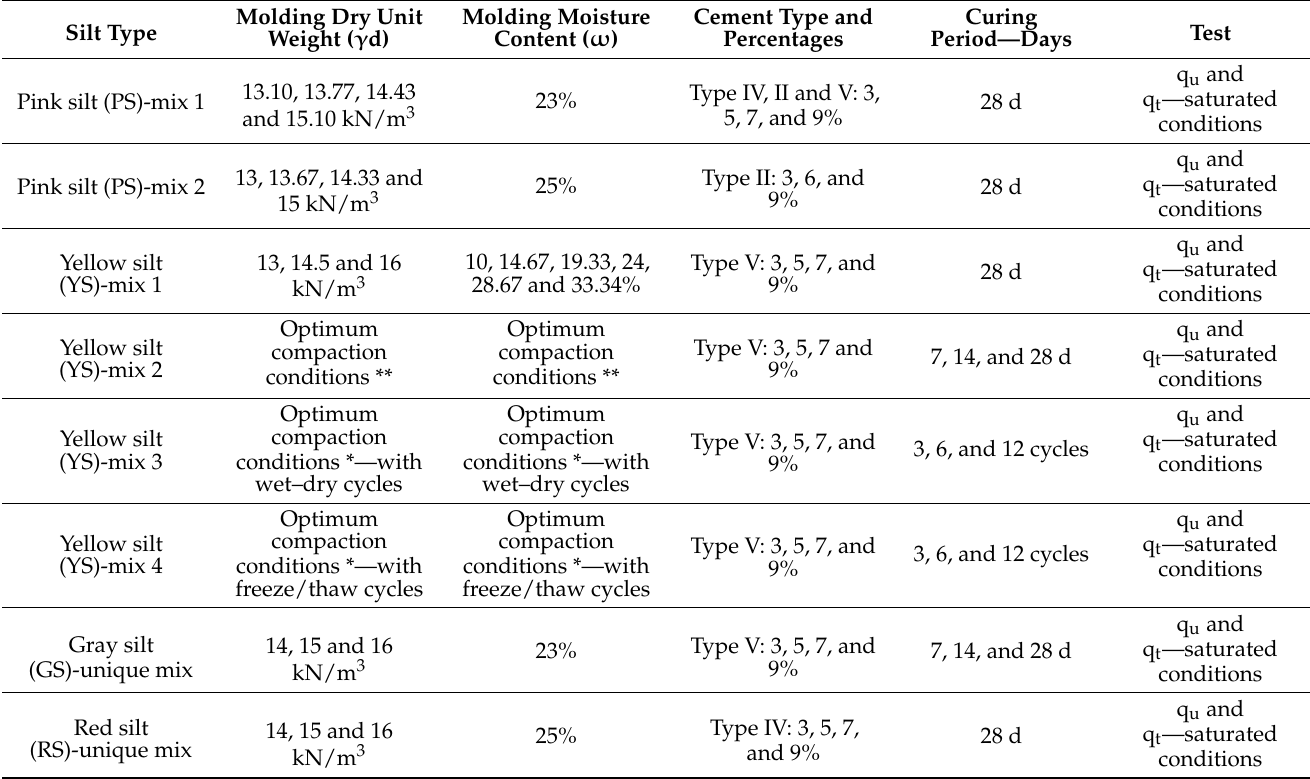
Table 5. Molding conditions for silt-cement mixes.